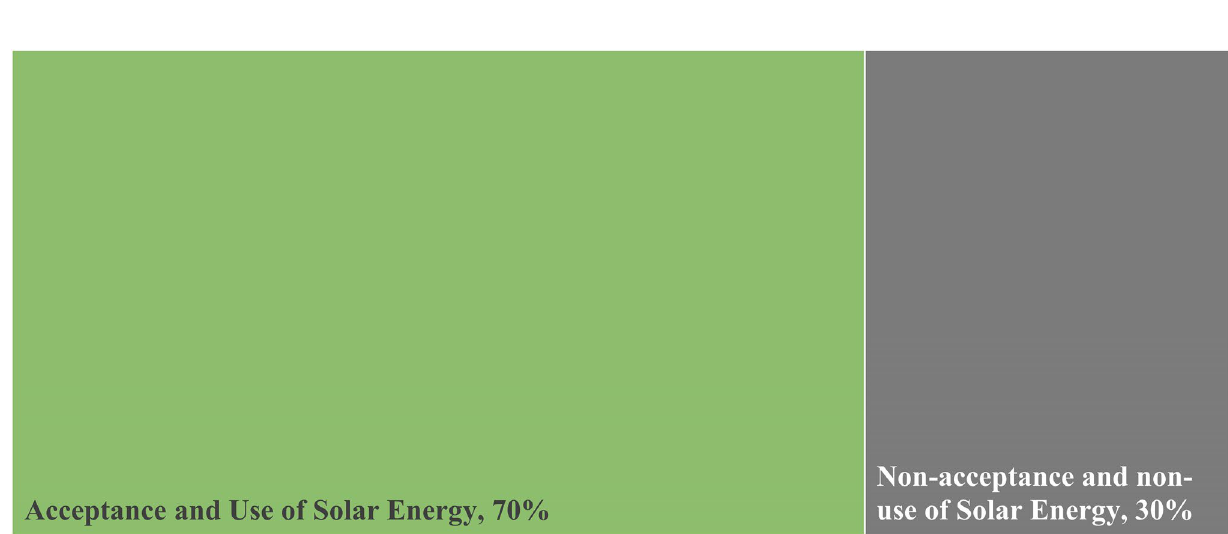
Source: researchers’